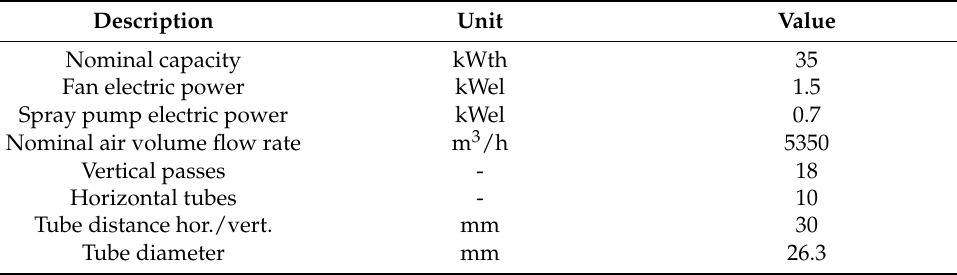
Table 1. Key characteristics of the investigated cooling